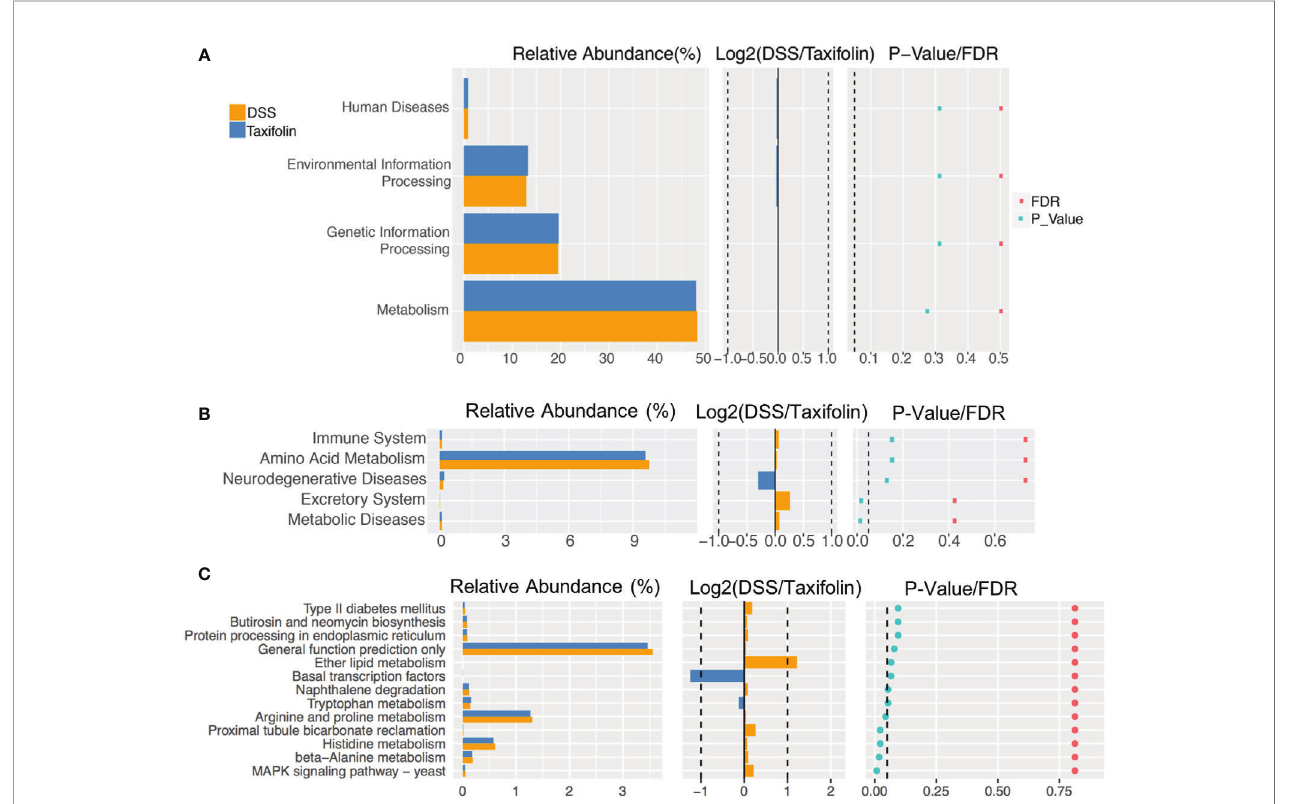
FIGURE 7 | The pathway of different abundances of micro fl ora at KEGG levels 1 (A) , 2 (B) and 3 (C)